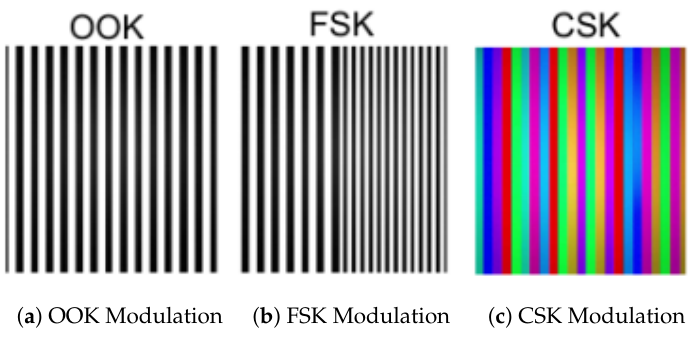
Figure 3. Modulation Patterns.